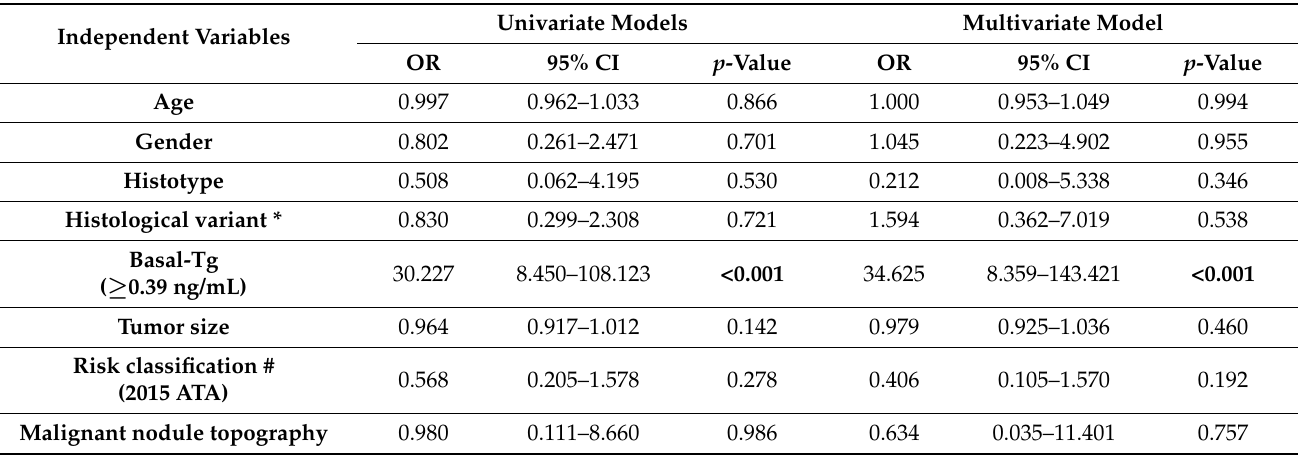
Table 7. Univariate and multivariate logistic regression analysis for positive 123 I-Dx-imaging after initial treatments: basal-Tg ≥ 0.39